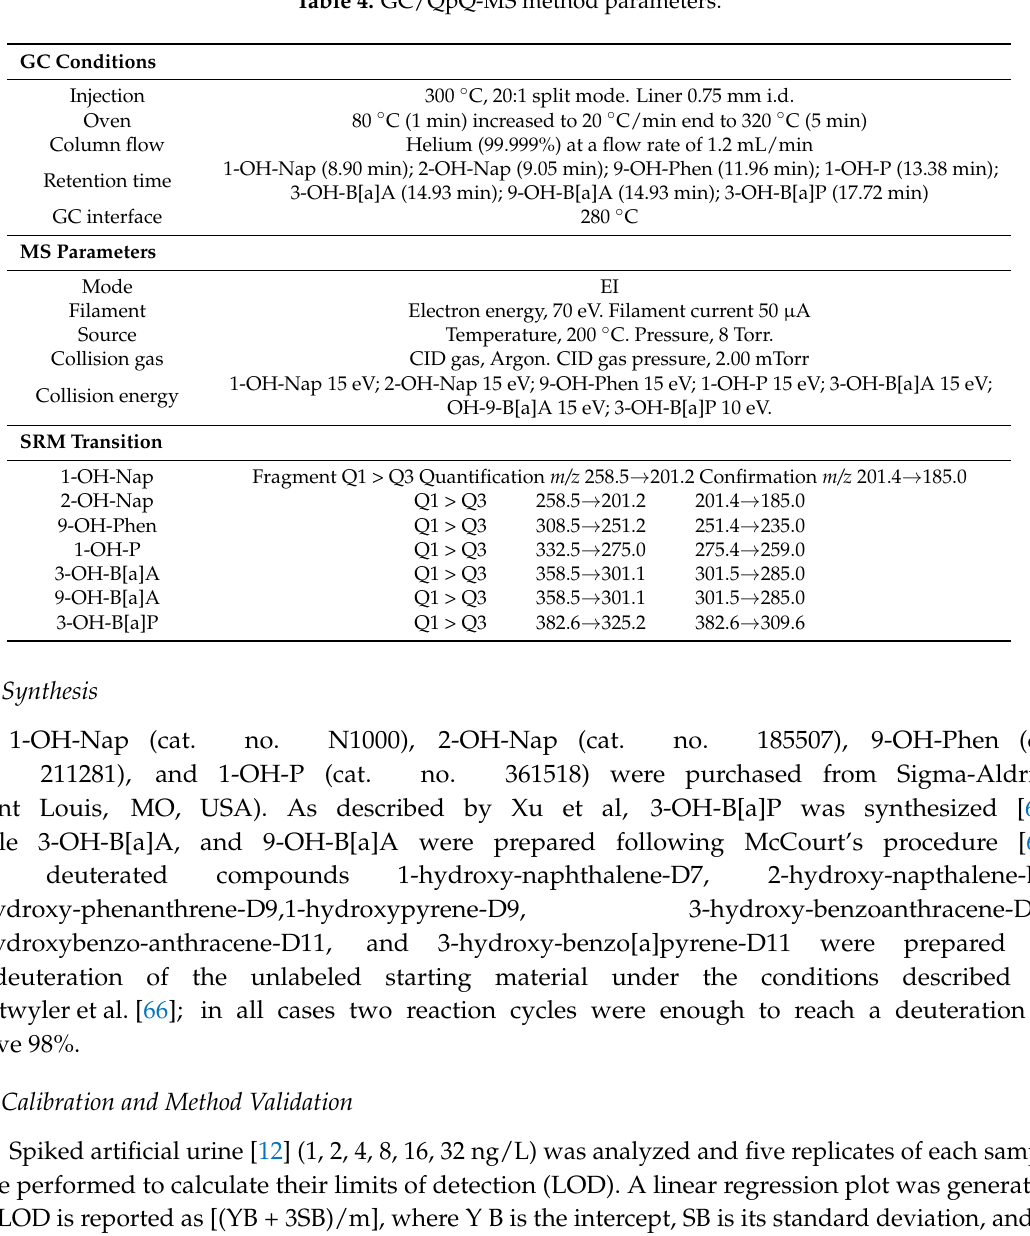
Table 4. GC/QpQ-MS method